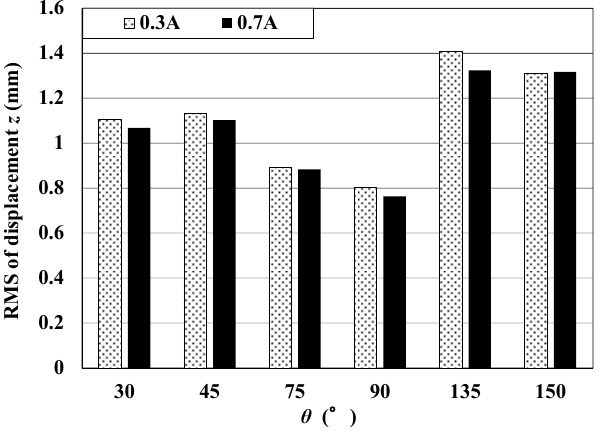
Figure 7. The RMS of displacement in the z direction of the steel plate at each steady current value.